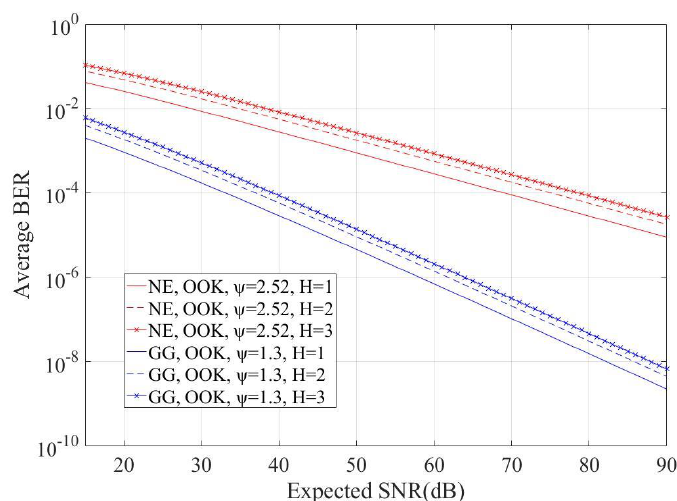
Figure 2. ABER ofOOK scheme versus the expected SNR.